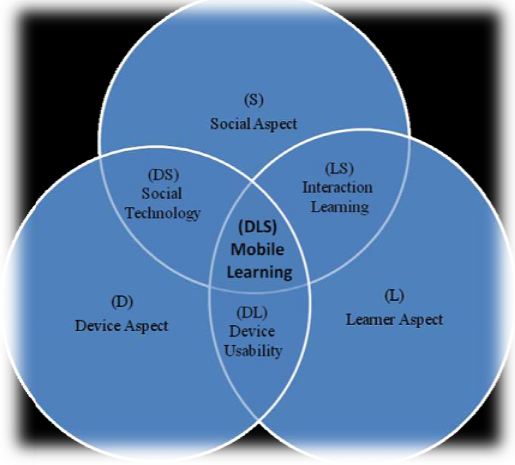
Figure 1 . Koole’s Mobile Learning